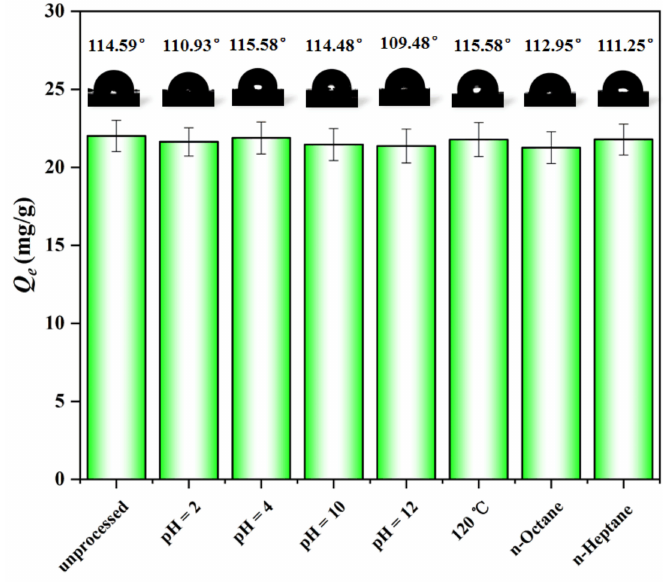
Figure 5. The environmental adaptability study of